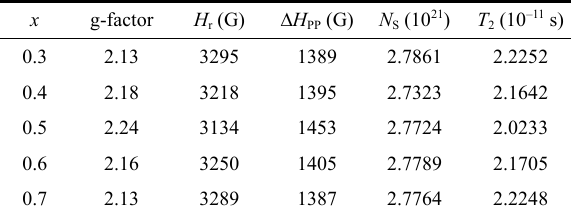
Table 8 Variation of g-factor, Δ H PP , H r , N S , and T 2 for Mg 1– x Zn x Fe 2 O 4 ( x = 0.3, 0.4, 0.5, 0.6, and 0.7) NPs